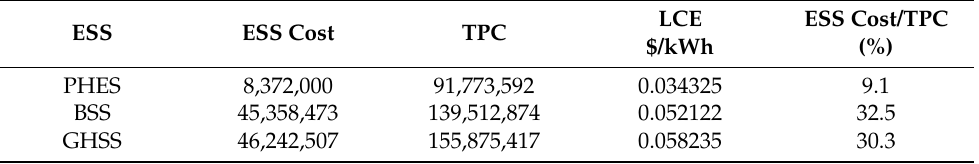
Table 5. The cost comparison between the three different ESS used in this study.